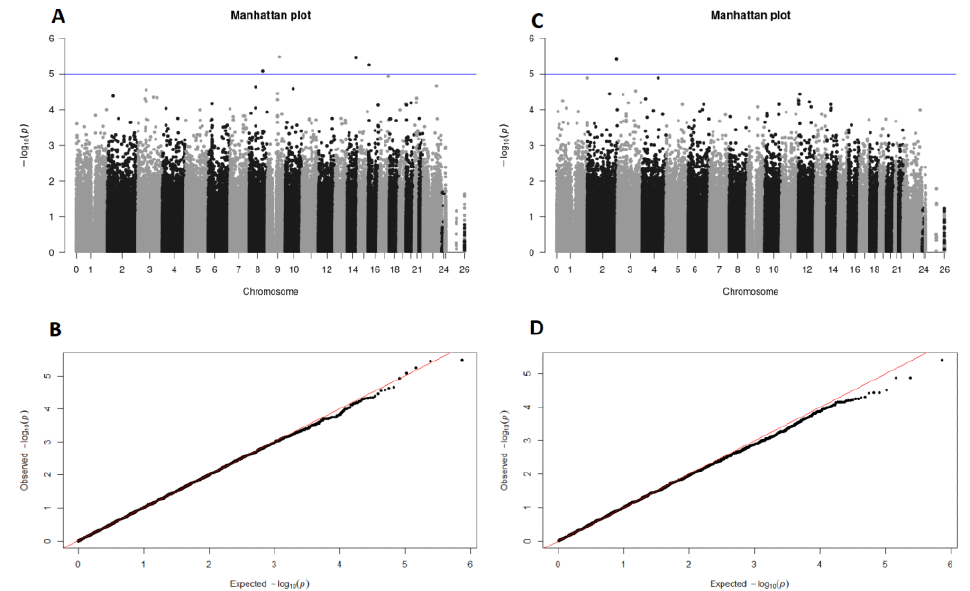
Figure 2. ( A , C ) Manhattan plots of genome-wide-association study data show SNPs associated with overweight ( A ) and obesity ( C ). The X axis represents the genomic coordinates of SNPs on respective chromosomes, while the Y axis represents the significance level on a −log 10 scale. The suggestive- significance threshold is indicated by the blue horizontal line ( p -value = 10 −5 ). Four SNPs were found to be associated with overweight ( A ) and one SNP with obesity ( C ); ( B , D ) quantile–quantile plots of the association analysis between men with normal BMI and overweight men ( B ) and between men with normal BMI and obese men ( D ). The X axis represents the expected significance level on a − log 10 scale, while the Y axis represents the observed significance level on the same